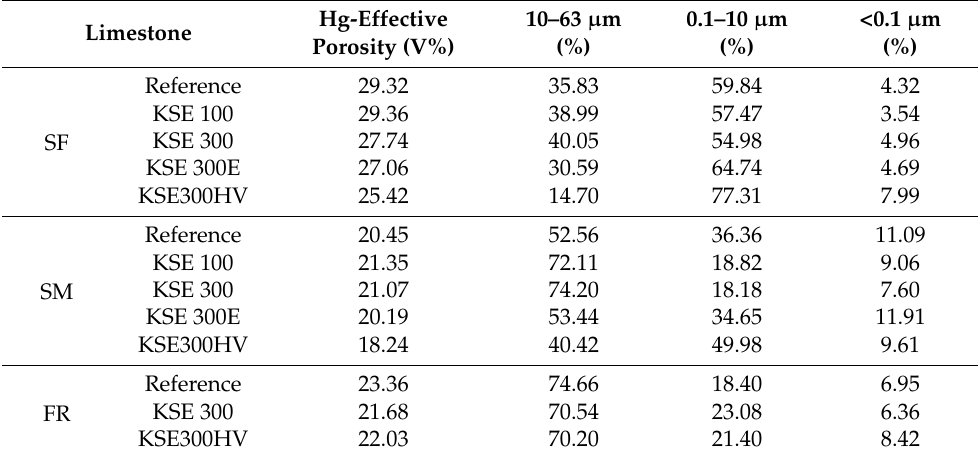
Table 4. Results of the MIP on untreated and treated